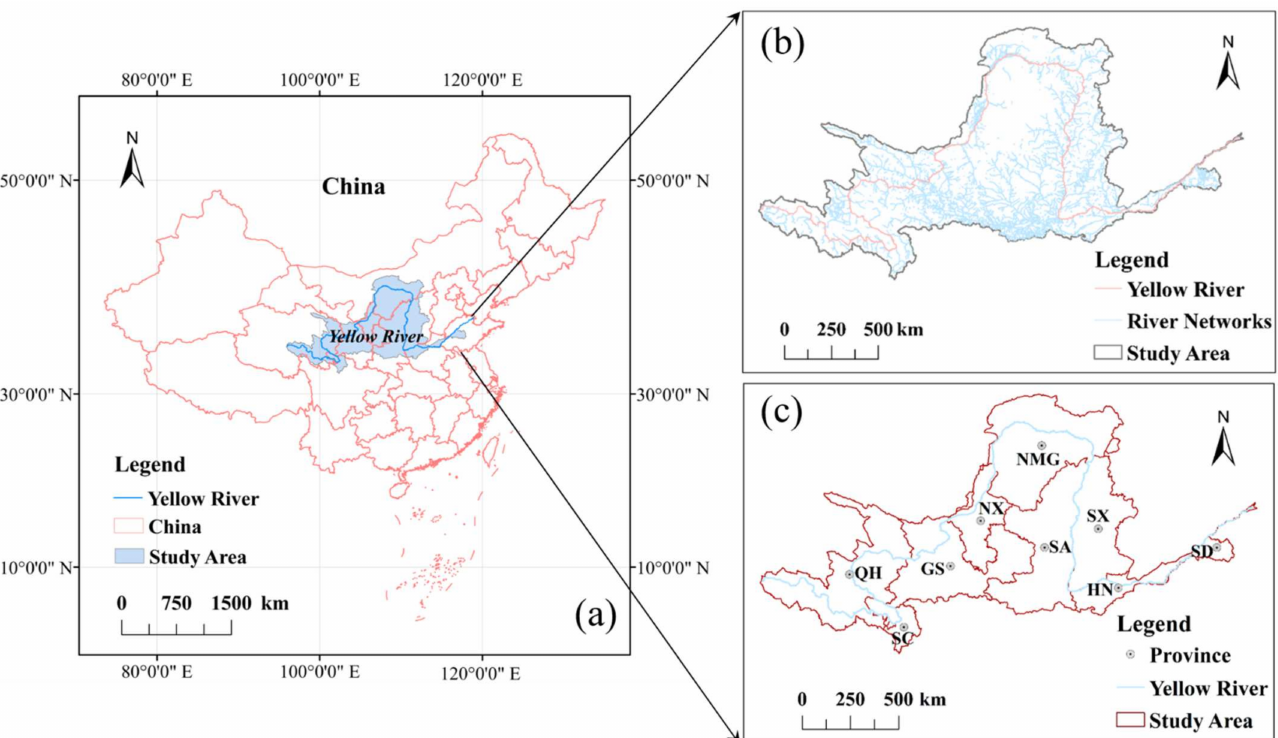
Figure 1. Study Area: ( a ) Location of the Yellow River Basin in China; ( b ) the river network of the Yellow River Basin; ( c ) The provinces included in the Yellow River Basin: Qinghai Province (QH), Sichuan Province (SC), Gansu Province (GS), Ningxia Hui Autonomous Region (NX), Inner Mongolia Autonomous Region (NMG), Shaanxi Province (SA), Shanxi Province (SX), Henan Province (HN), and Shandong Province